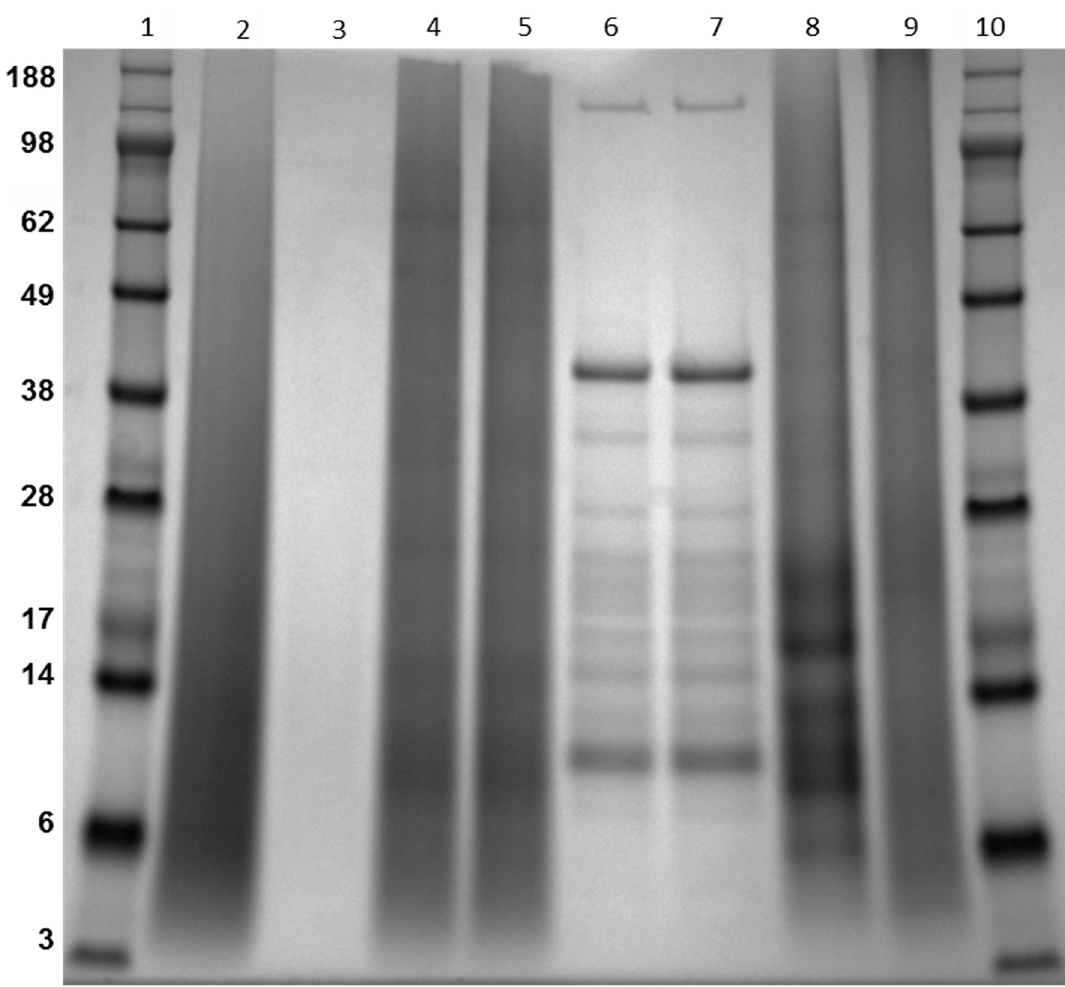
Fig 1. Coomassie blue stained Bis-Tris gel showing 7 PPD preparations. Note the striking differences in traditional production PPDs (lanes 2, 4 and 5 for example) in comparison to the alternative production method (lanes 6 and 7). Lane assignments include: 1 and 10-protein standards; 2-Lot #9801 PPD; 3-Lot 9801 at a 1:10 dilution; 4-Lot 0802; 5-Lot 0803A; 6-Lot 0902A; 7-Lot 0902B; 8- M . bovis PPD; 9 – M . avium PPD. Molecular mass standards are indicated in the left margin in